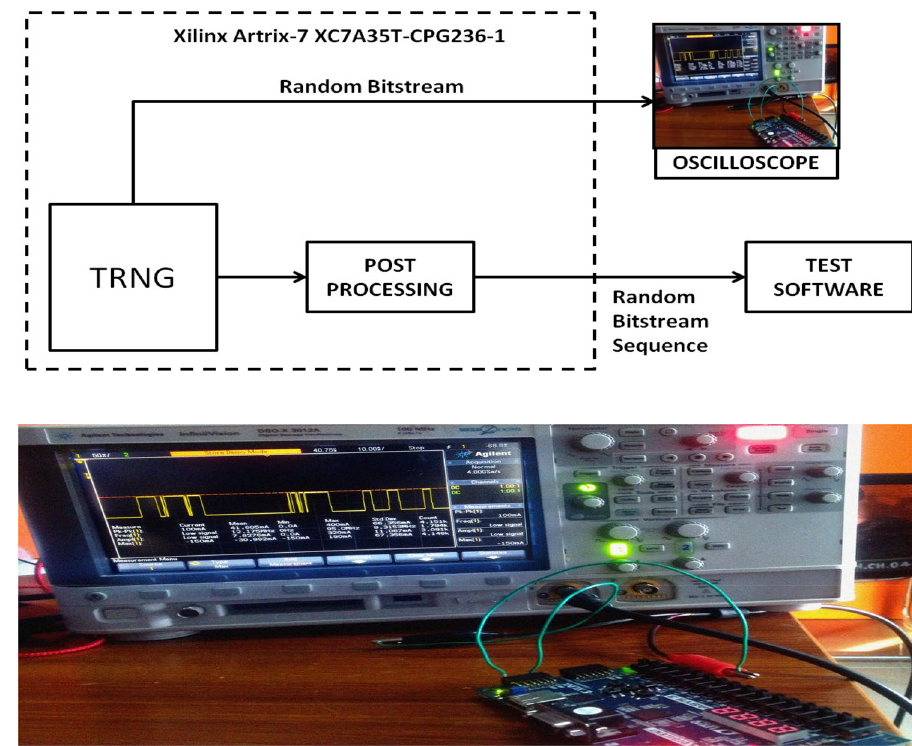
Fig. 13 Experiment setup of FPGA interface with DSO for the TRNG’s using ADPLL